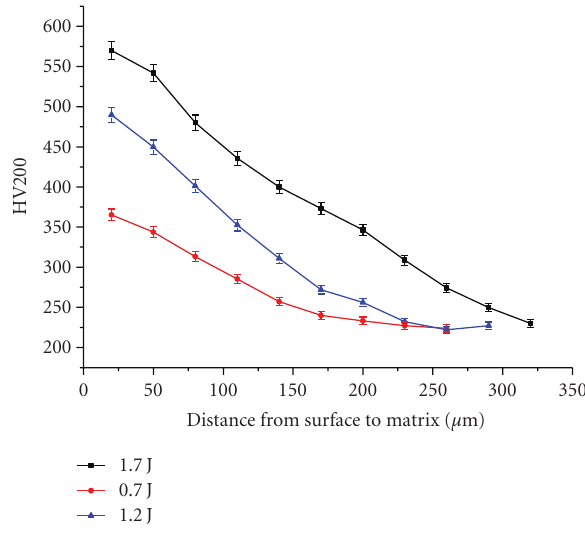
Figure 7: Curves of microhardness of the HMS after impact- corrosion wear for 16 hours.